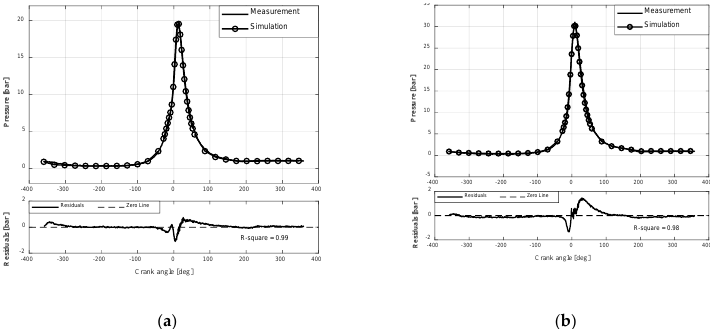
Figure 3. Simulated and measured in-cylinder pressure for the Engine A at different operating conditions: ( a ) 25% load; ( b ) 50% load. Table 5. Comparison between the simulated and the measured parameters for Engine A.